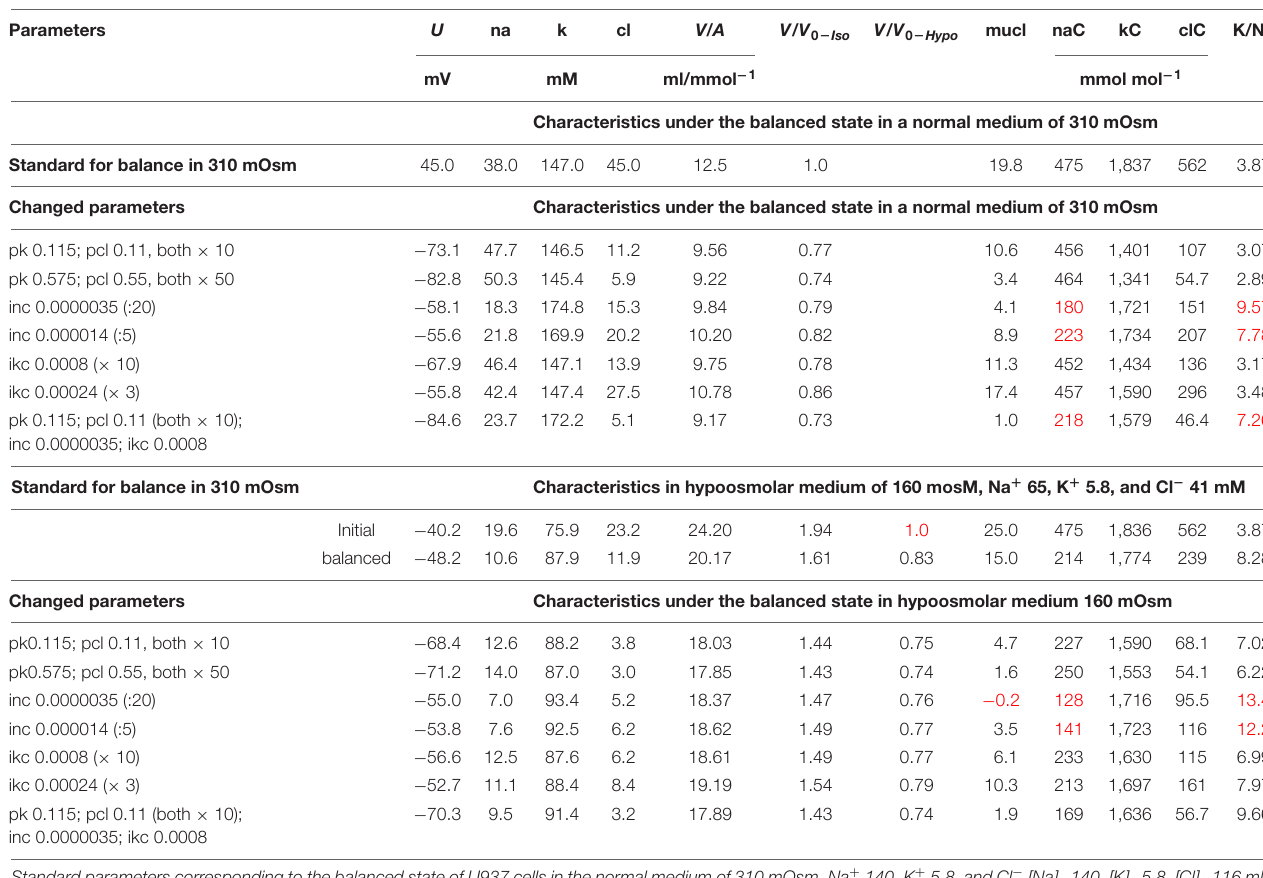
Standard parameters corresponding to the balanced state of U937 cells in the normal medium of 310 mOsm, Na + 140, K + 5.8, and Cl − [Na] o 140, [K] o 5.8, [Cl] o 116 mM are as follows: pna 0.0017; pk 0.0115; pcl 0.011; inc 0.00007; ikc 0.00008; inkcc 0.000000008; V 0 − Iso and V 0 − Hypo −−− initial cell volumes in isotonic and hypotonic medium, respectively. Stronger NC effects are marked in